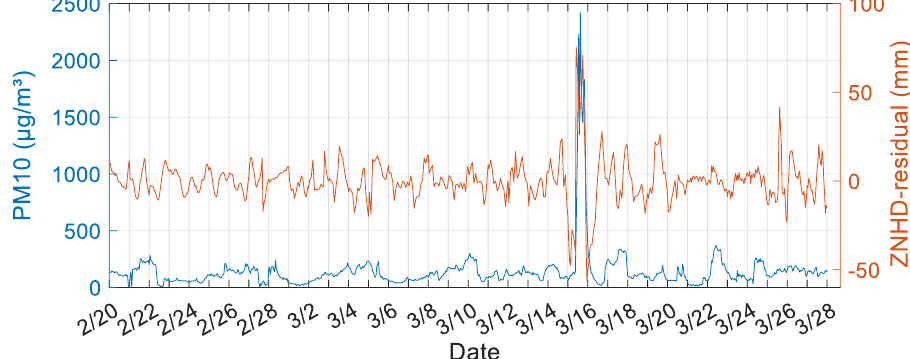
Figure 8. Variations in the PM10 and the ZNHD residual at the BJFS station.